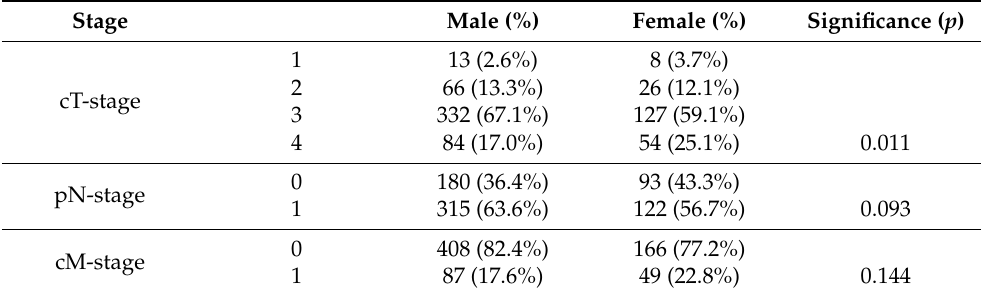
Table 1. Tumor stage according to gender of the entire